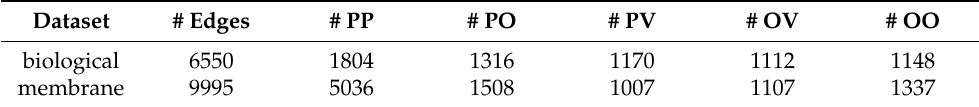
Table 2. Statistics of edges of the heterogeneous networks of the biological computing and membrane computing